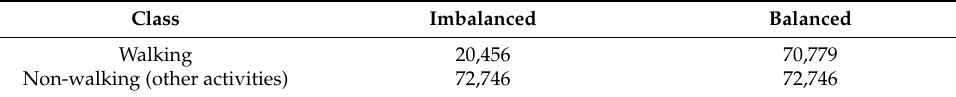
Figure 5. Scatter plots of two arbitrary features for walking and non-walking classes: ( a ) Imbal- anced and ( b ) Balanced. The red and blue circles represent the Walking and Non-walking classes, respectively. Table 3. Number of segments for imbalanced and balanced